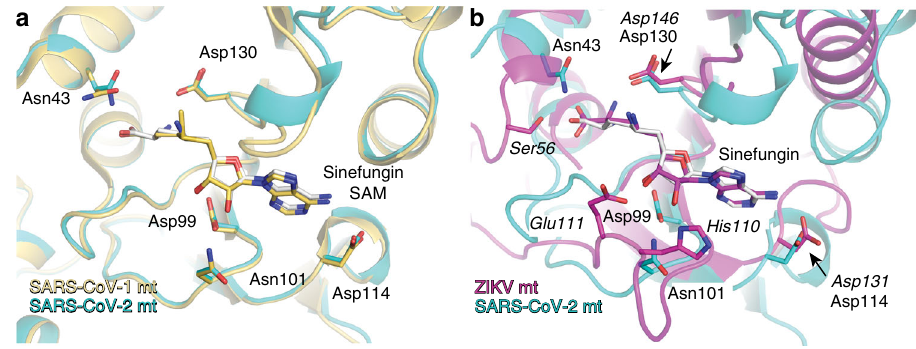
Fig. 6 Structural alignment of MTase active sites from SARS-CoV-2 with SARS-CoV and ZIKV. a SARS-CoV-2 and SARS-CoV MTase. b SARS-CoV-2 and ZIKV MTase. SARS-CoV-2 nsp16 is shown in cyan, SARS-CoV nsp16 in beige, and ZIKV MTase in magenta. Conserved pairs of residues SARS-CoV-2 Asp114 & ZIKV Asp131 and SARS-CoV-2 Asp130 & ZIKV Asp146 are highlighted by arrows.